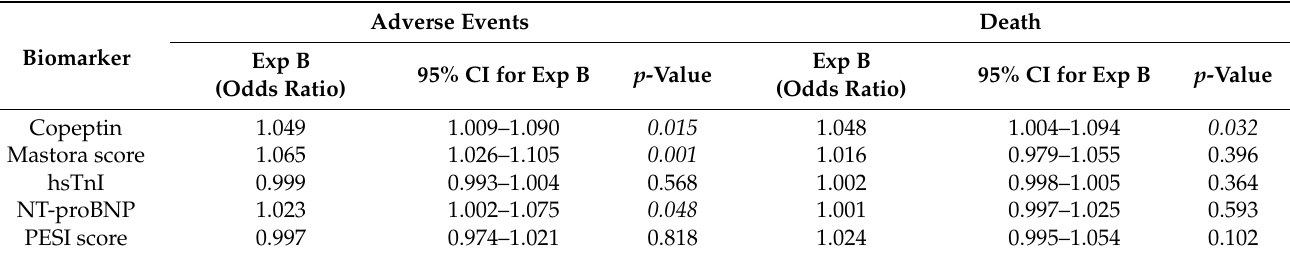
Table 6. Binary logistic regression analysis for adverse events and death in the PE